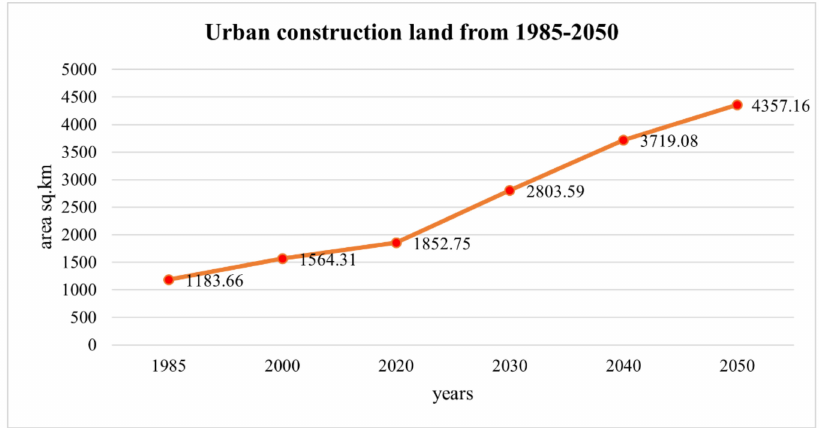
Figure 14. Choronological area changing trend status of urban CL from 1985 to